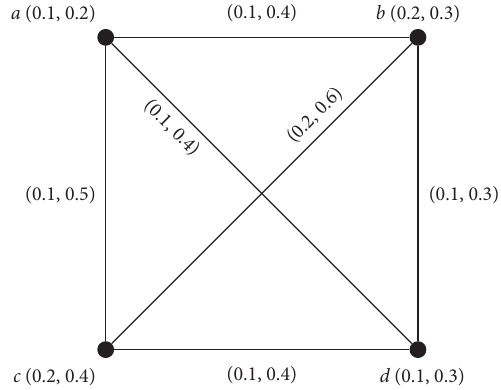
Figure 6: Vague subgraph G ′ of the vague graph G of Figure